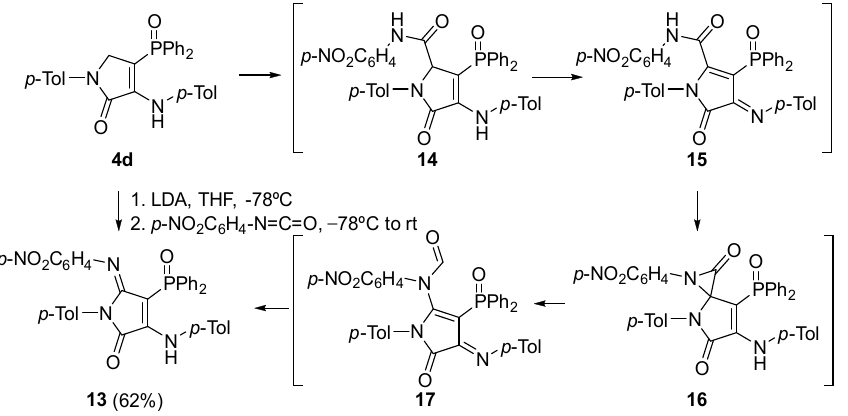
Scheme 5. Unexpected γ -lactam derivative 13 obtained by nucleophilic addition of γ -lactam 4d to isocyanates.